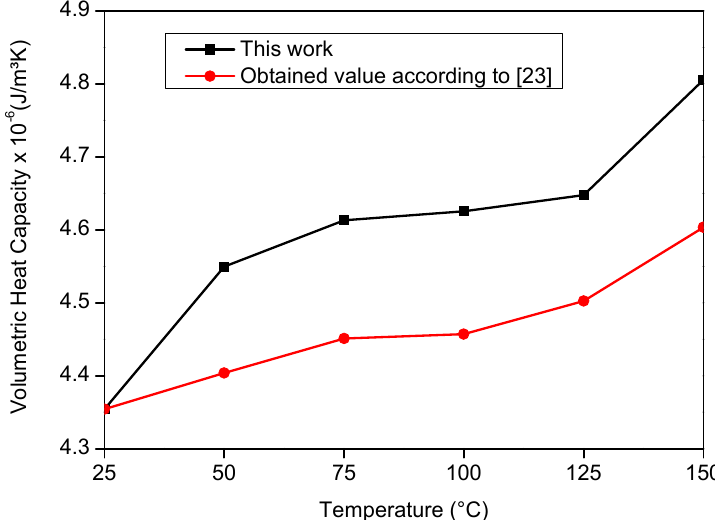
Figure 15. Comparison between the literature values with the estimated results of ρ c p on the AISI 304 stainless steel sample.